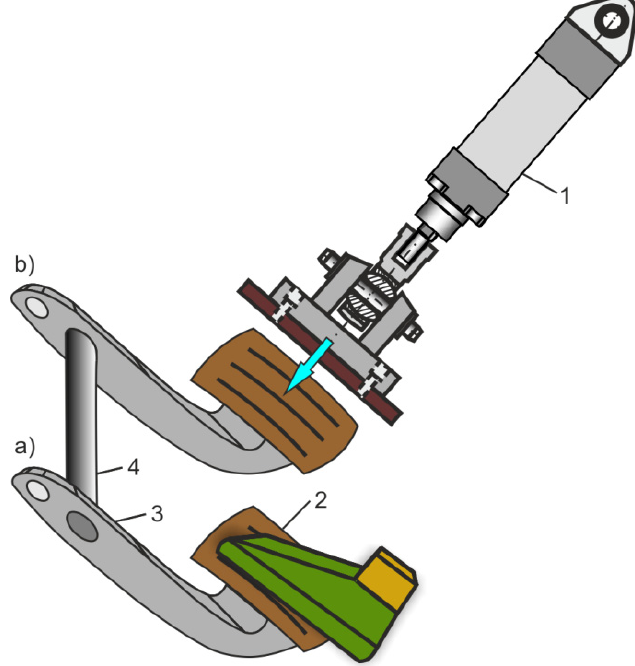
Figure 1. Dual foot brake pedals: a) primary driver brake pedal, b) pneumatically actuated secondary brake pedal, 1 – pneumatic actuator assembly, 2 – brake pedal pad, 3 – brake pedal arm, 4 – tubular shaft.